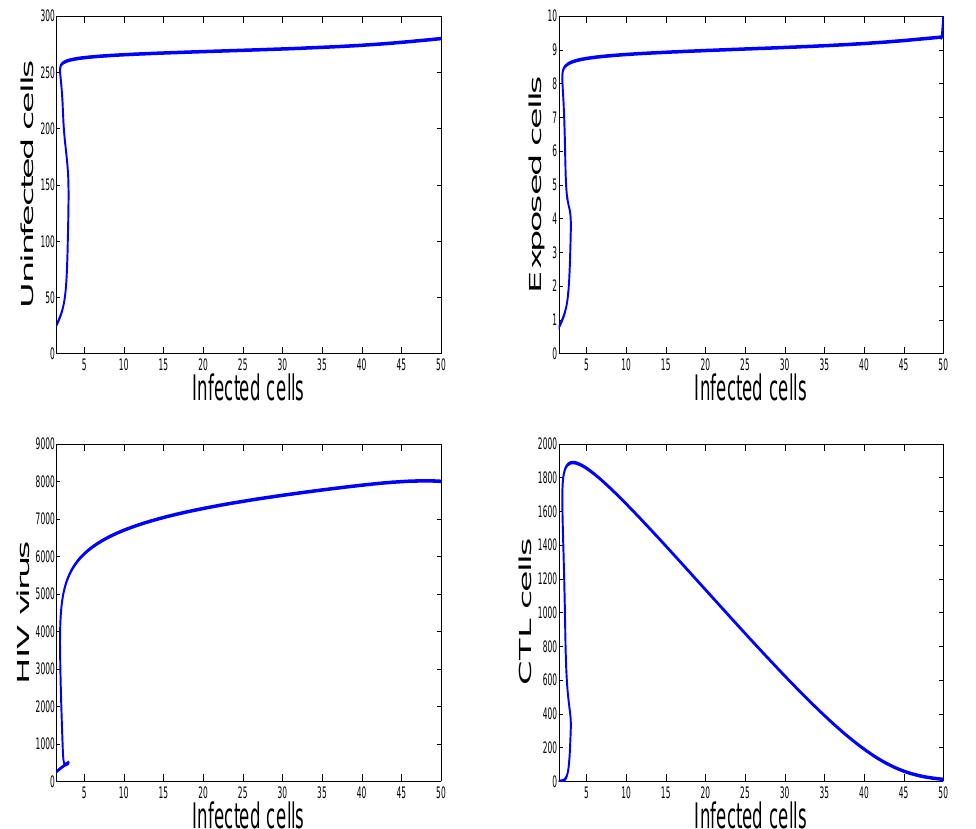
Figure 5. Selective phase portraits to illustrate the solution behavior of the infection dynamics when λ = 1, d 1 = 0.0139, k 1 = 0.04, d 2 = 0.0495, k 2 = 1.1, d 3 = 0.5776, a = 100, d 4 = 0.6, p = 0.0024, c = 0.15, b =